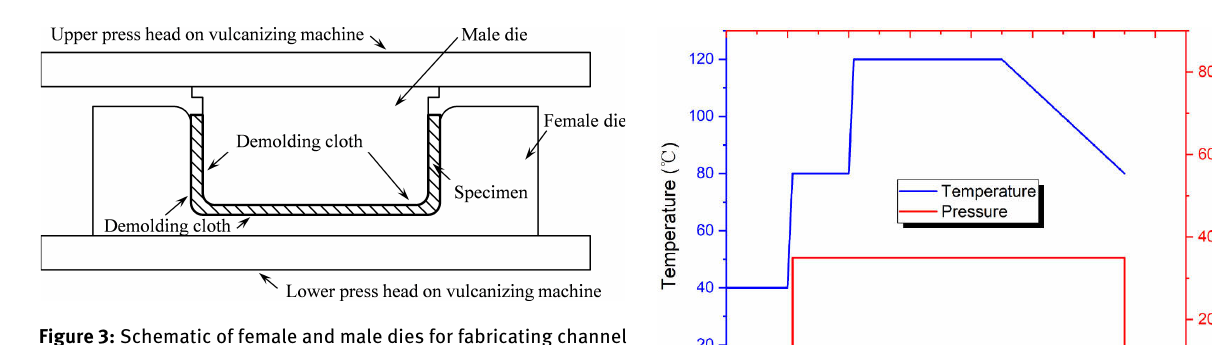
Figure 3: Schematic of female and male dies for fabricating channel cross-sectional members.